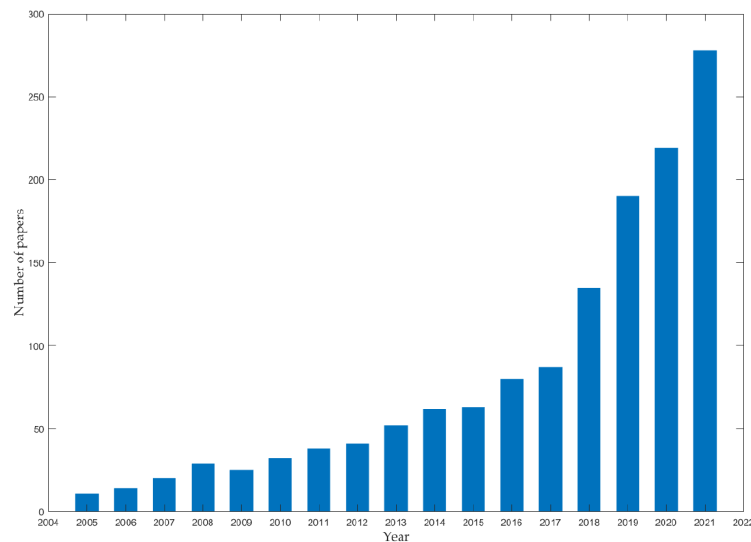
Figure 1. Number of papers and patents published each year.